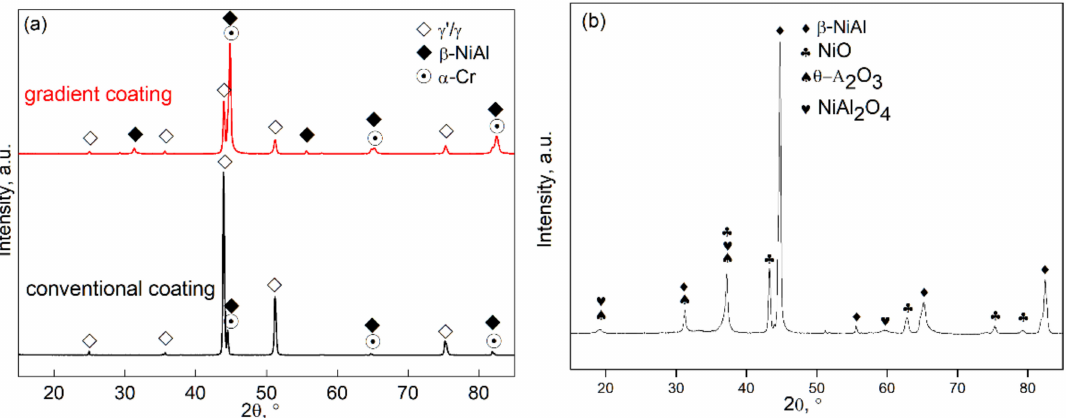
Figure 1. XRD patterns of the three coatings in the as-received state: ( a ) the conventional and gradient coatings; ( b ) the preoxidised coating.